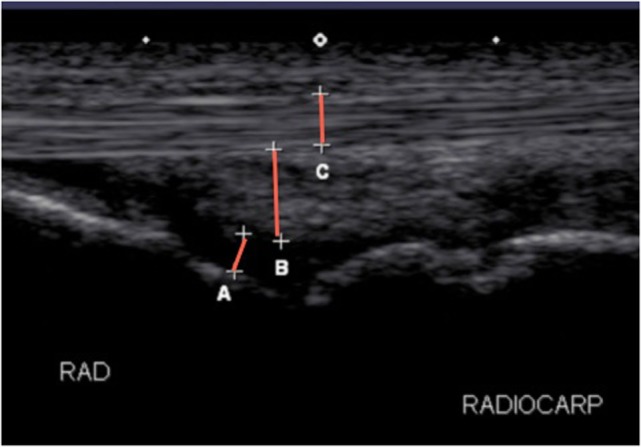
Longitudinal ultrasonographic image of a radiocarpal joint detailing the measurements performed in the study for joints. (A) Joint fluid, (B) joint capsule, and (C) tendon and total depth were measured at the same site from skin to bone.